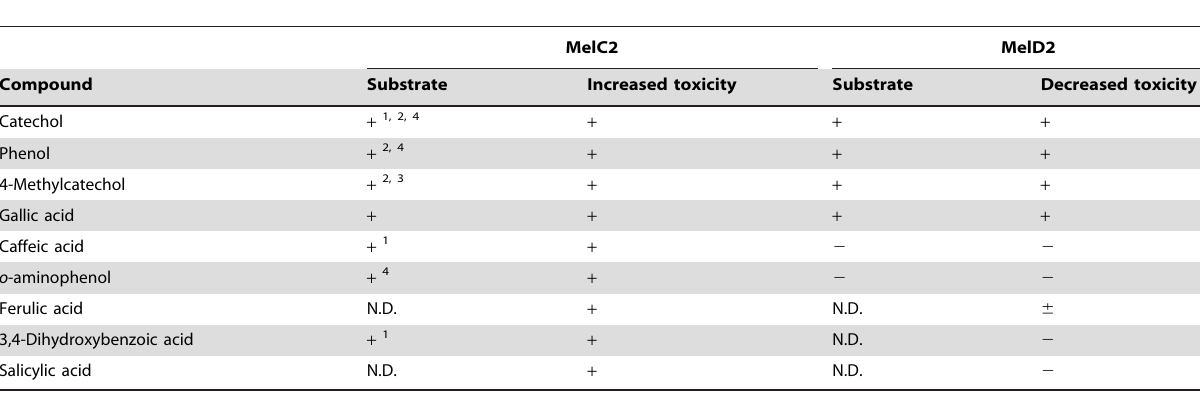
Table 2. Phenolic substrates of MelC2 and MelD2 and effect on